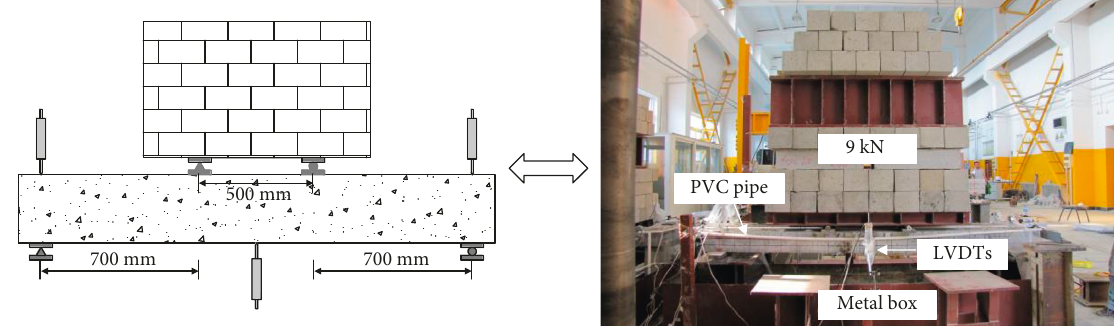
Figure 5: Schematic of the sustained loading test setup.